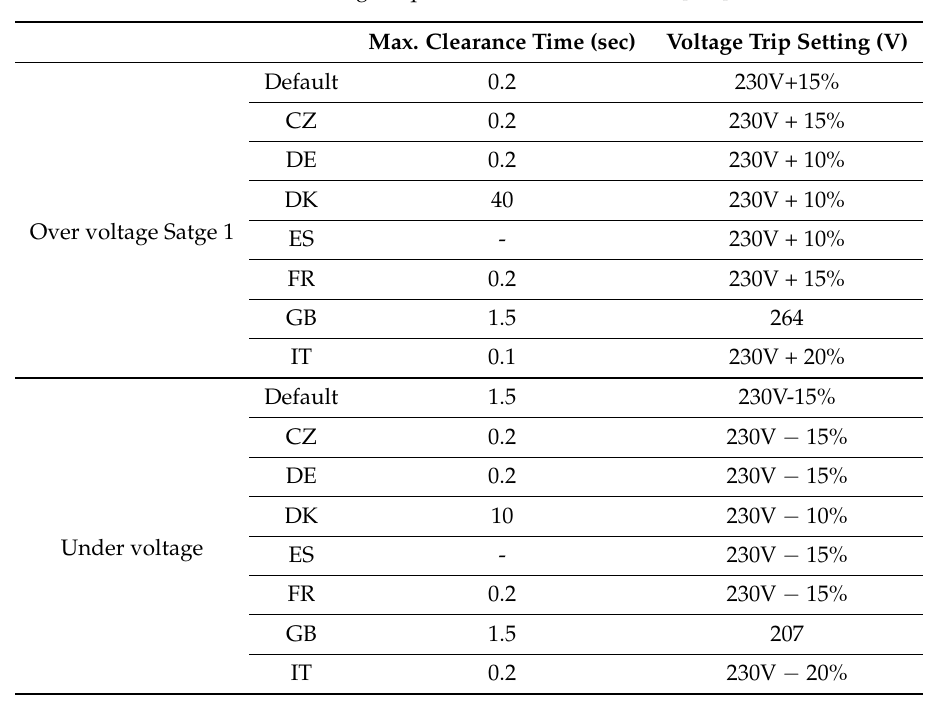
Table A2. Voltage requirements in EU countries [109].